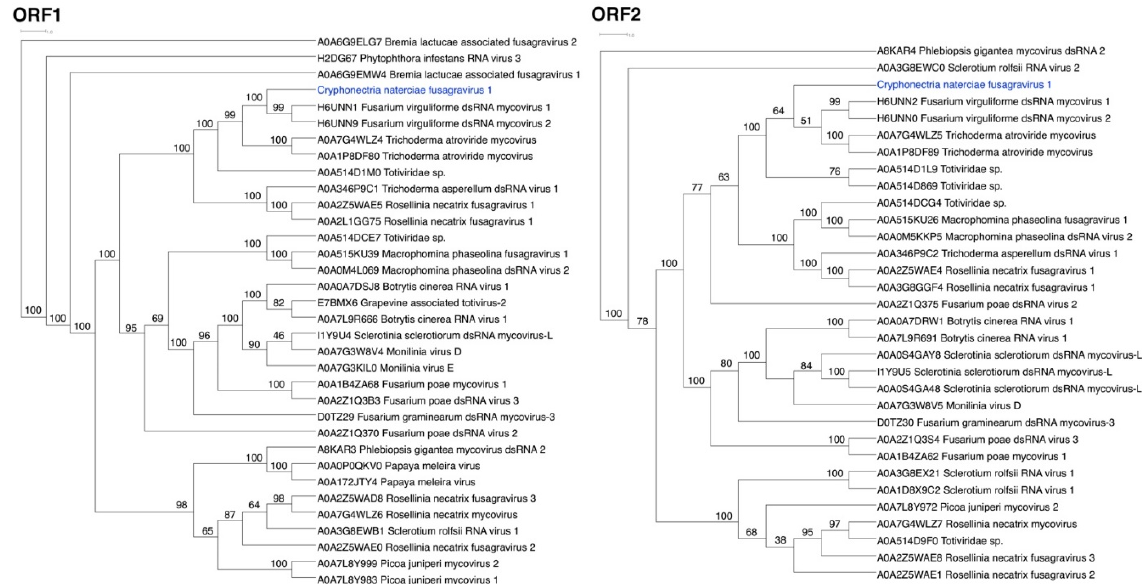
Figure 4. Phylogenetic analyses of amino-acid alignments resulting from ORF1 and ORF2 BLASTp searches of the new mycovirus Cryphonectria naterciae fusagravirus 1 (CnFGV1). Blue letters highlight the phylogenetic position of CnFGV1 in both neighbor joining trees. Names and UniProt accession numbers of related fusagraviruses included in the analyses are indicated in the trees. The numbers at nodes are values of >50% of 1000 bootstrap replicates.